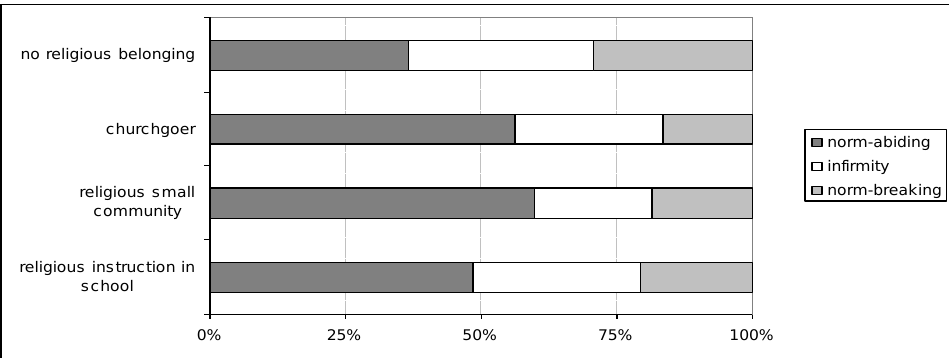
Figure 2. Level of moral awareness of undergrad students according to religious environment.